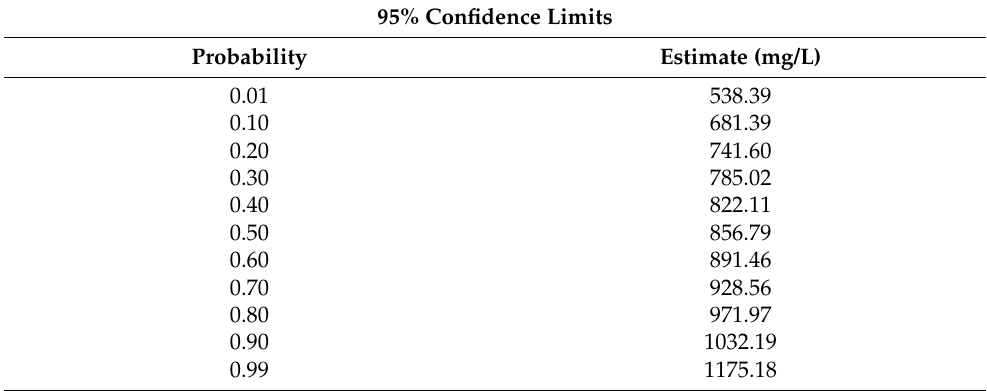
Table 1. Lethal concentration (LC 50 ) of hybrid grouper ( Epinephelus fuscoguttatus exposed to the different concentration of waterborne nitrite for 96 h.